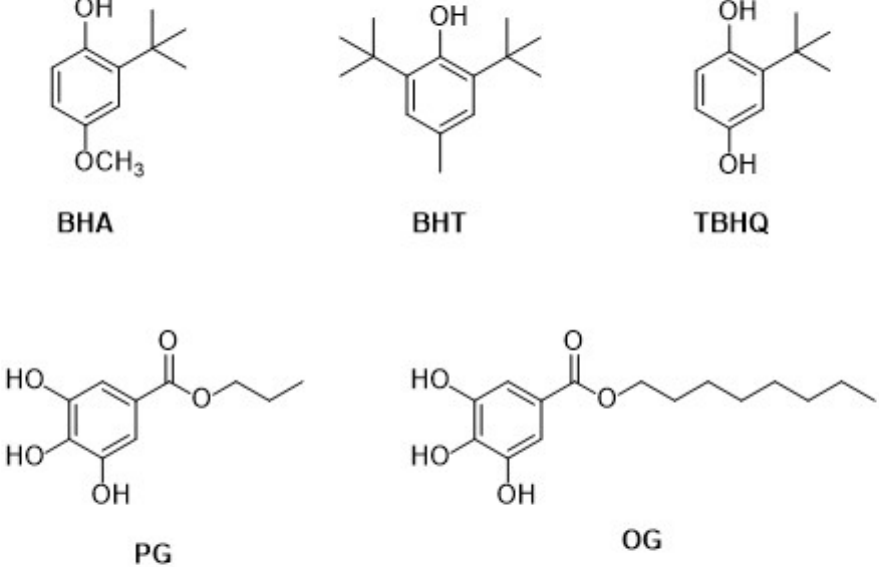
Figure 25. Chemical structure of the most common SPAs.